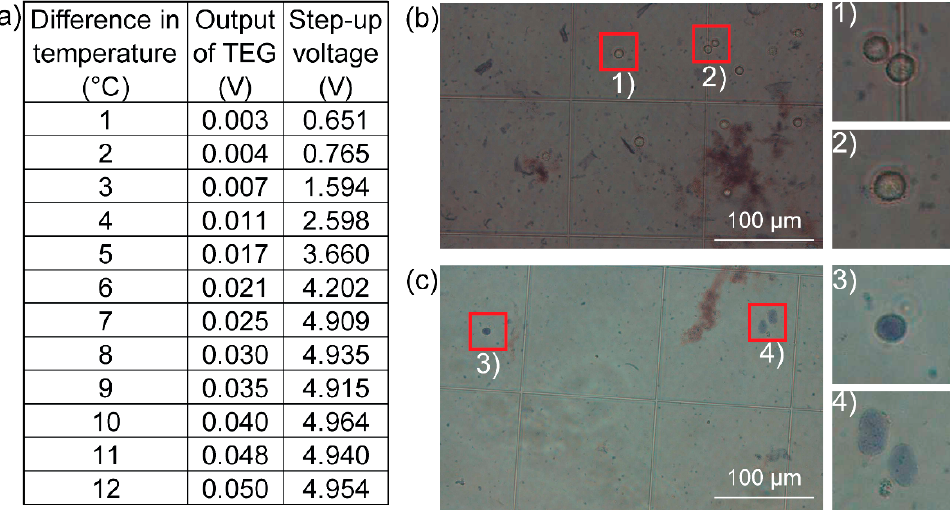
Figure 6. ( a ) Correlation between temperature and output voltage, ( b ) HeLa cells before electrical cell lysis, (1), (2) cells with intact membrane, and ( c ) HeLa cells after electrical cell lysis, (3) dead cell, (4) cells with disrupted membrane.